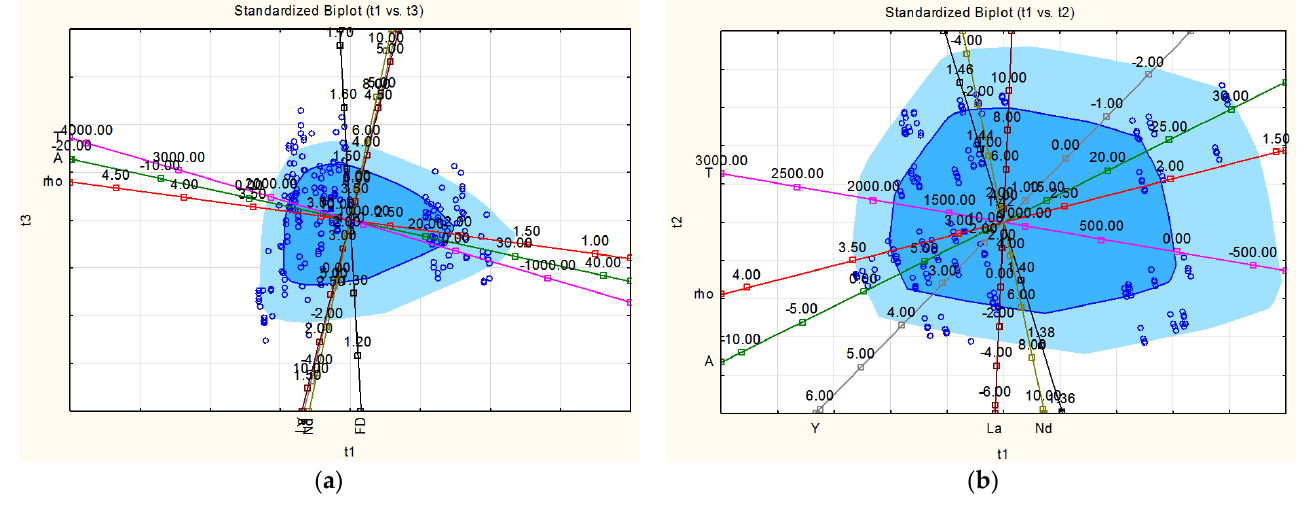
Figure 10. PCA biplots on: ( a ) PC1 and PC3 projection plane; ( b ) PC1 and PC2 projection plane, (Note: missing label of the black axis is FD).